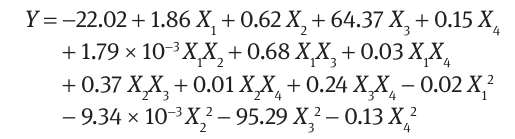
Table 2: Levels and codes used in Box-Behnken design. Variable